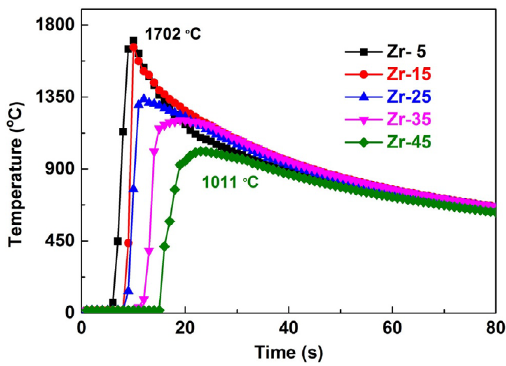
Fig. 2 Real temperature curve of all samples during SHS eight percentage of reductant and oxidant. Because